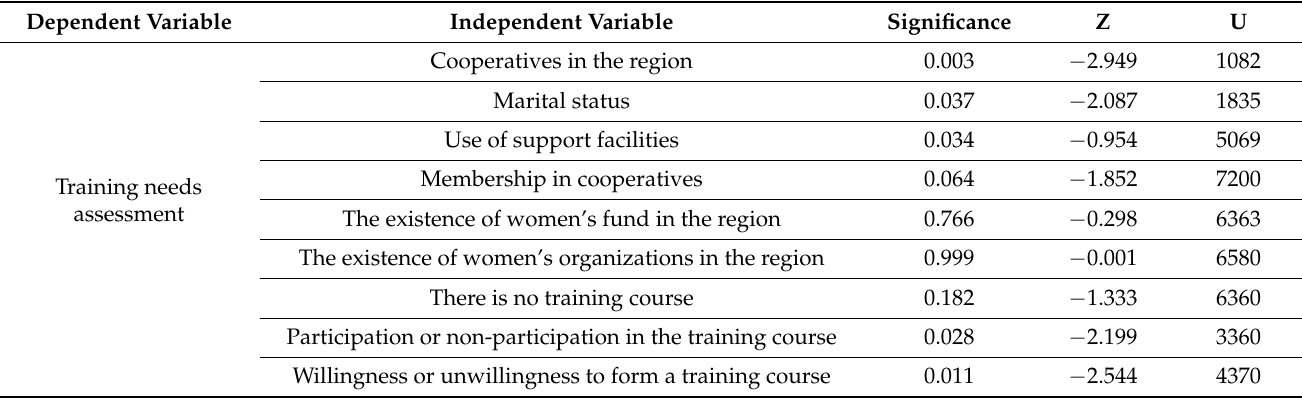
Table 4. Results of the Mann–Whitney